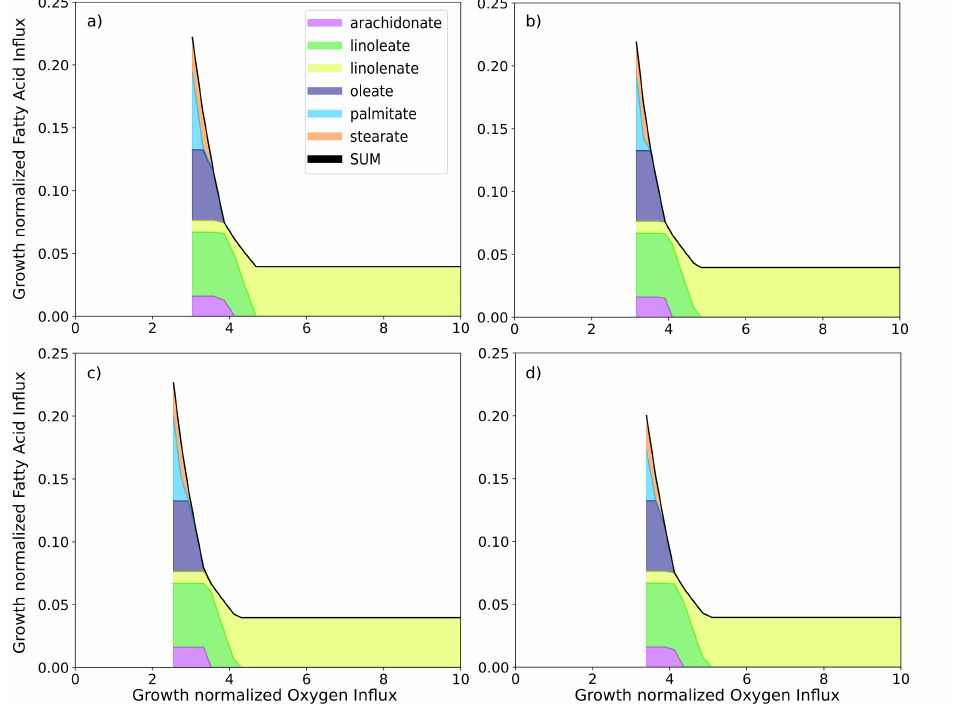
Figure 4. Simulating minimum fatty acid uptake requirement in response to various oxygen uptake constraints. Oxygen influx constraints were applied to each of the model instances ( a ) sensitive, ( b ) oxaliplatin-resistant, ( c ) sensitive in DMSO-containing medium, and ( d ) BOLD-100/KP1339-resistant. Using a parsimonious thermodynamic flux variability analysis (pTFVA; see Methods and Materials for details) the minimum possible fatty acid uptake was calculated for each oxygen constraint as shown. Fatty acid influx is the combined influx (black line) of stearate (orange), palmitate (cyan), oleate (dark purple), linolenate (yellow), linoleate (green), arachidonate (light